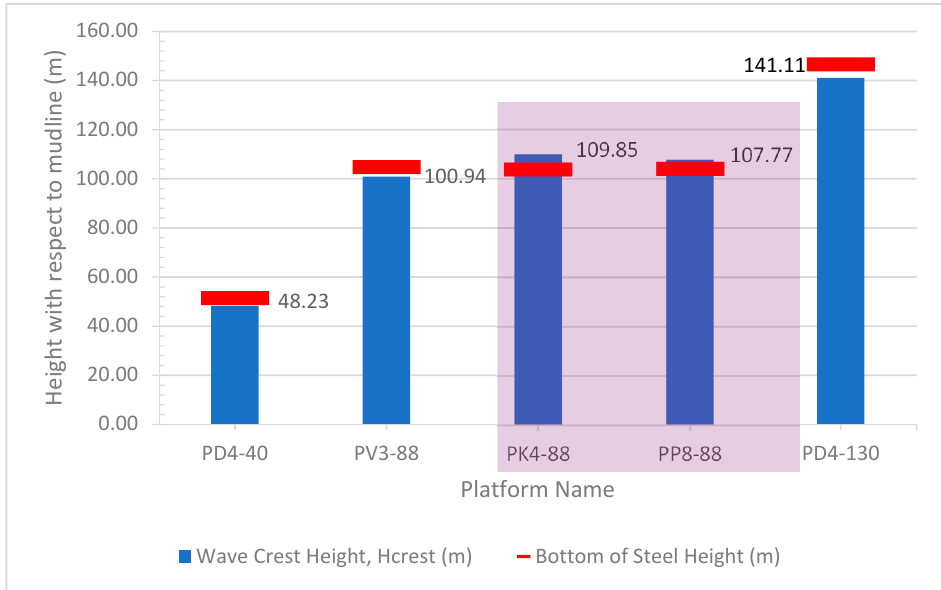
Figure 7. Comparison of bottom steel height and wave crest height at collapse.